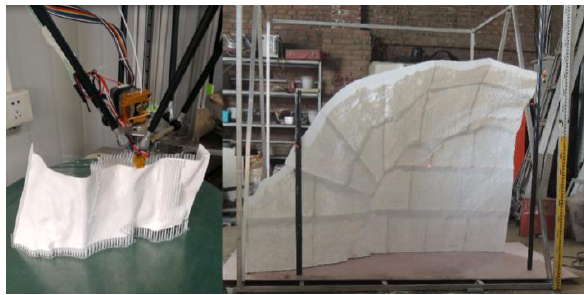
Figure 11. 3D printed